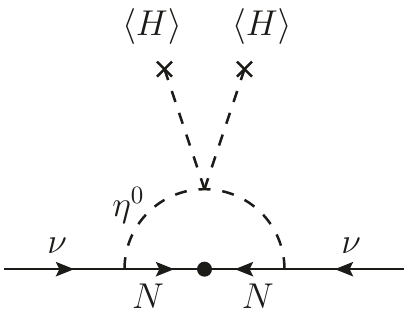
Figure 4 . Feynman diagram for neutrino mass generation in the scotogenic